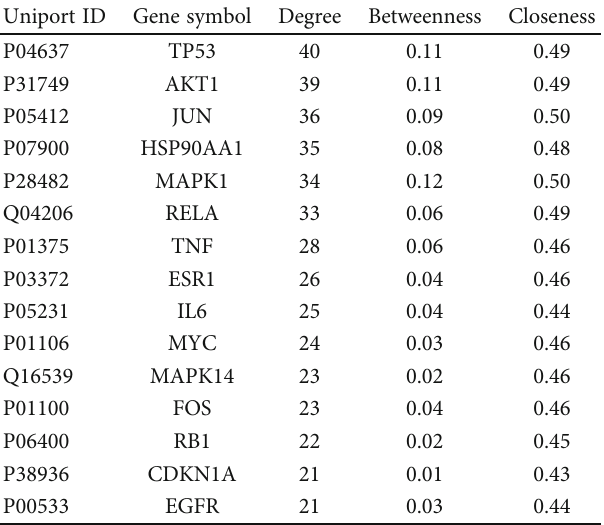
Figure 5: Gene ontology (GO) and Kyoto Encyclopedia of Genes and Genomes (KEGG) analyses. Di ff erent colors represent di ff erent P - values, and circle size represents the counts. (a) The top 10 GO terms. Red, blue, and green bars represent molecular function, cellular component, and biological process, respectively. (b) The top 30 KEGG pathways. Table 3: Core targets of PCRR in the treatment of ALF and the topological